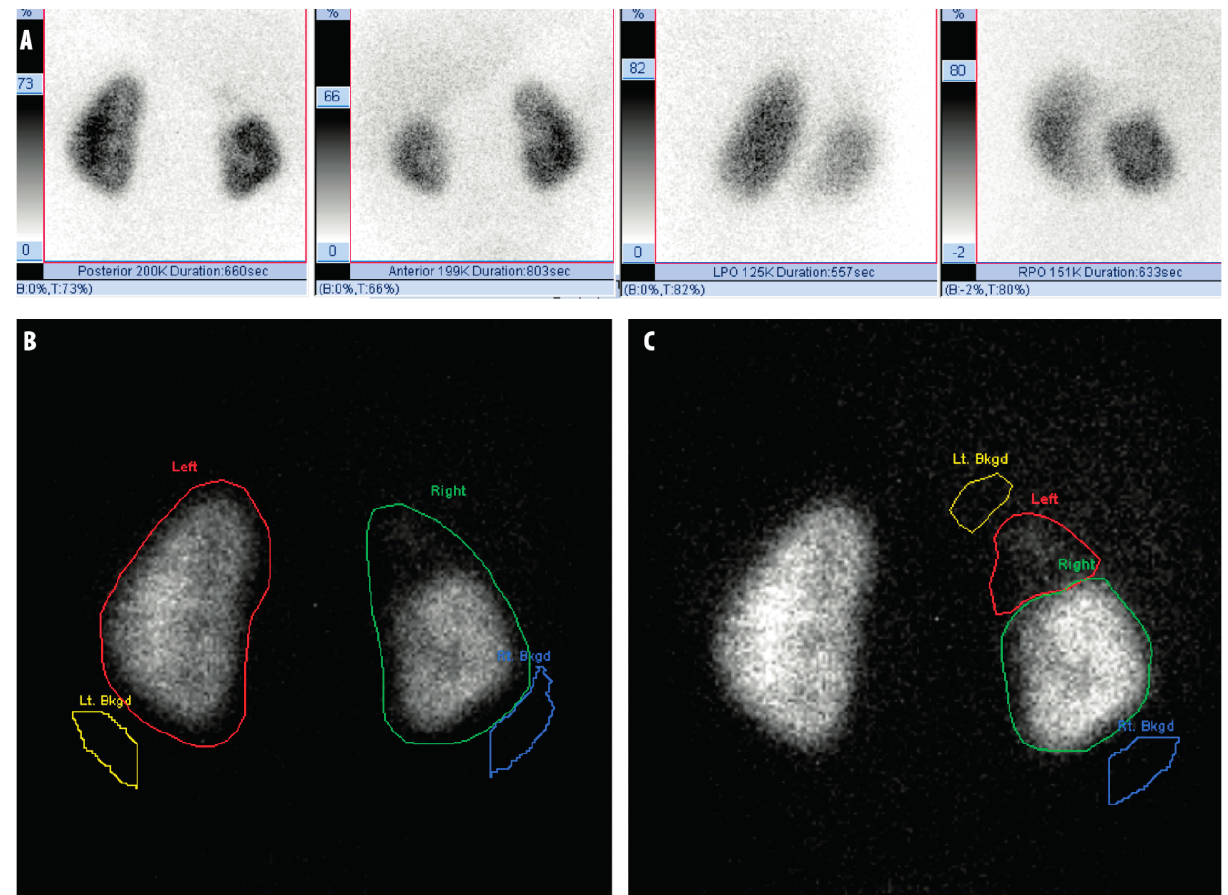
Fig. 1. Tc-99m dmsa scintigraphy. regions of interest, normal parenchymal accumulation of lower pole, poor visualisation of upper pole (differential function 7%), no lesions